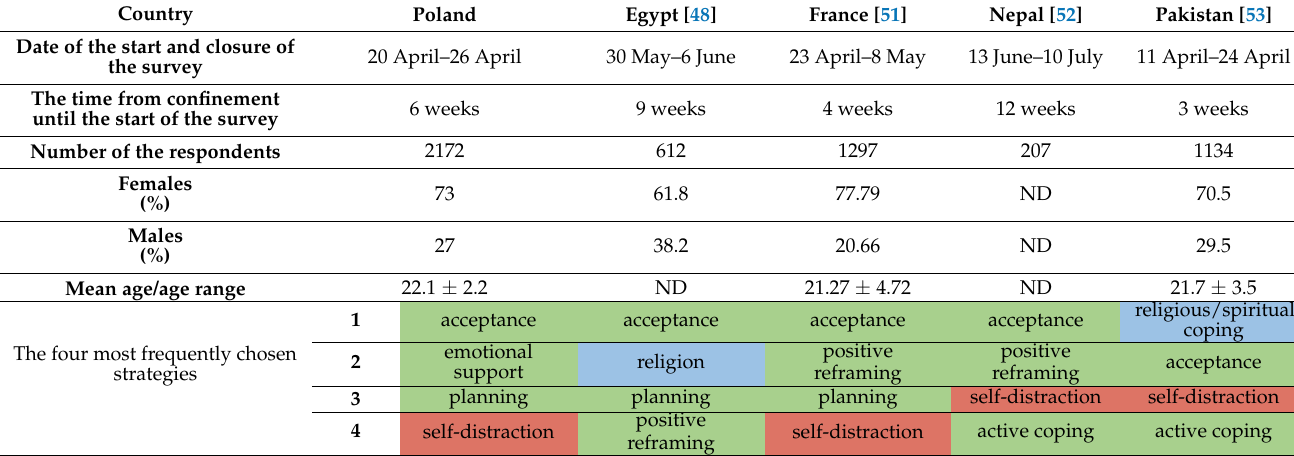
Table 6. Comparison between studies regarding most frequently chosen coping